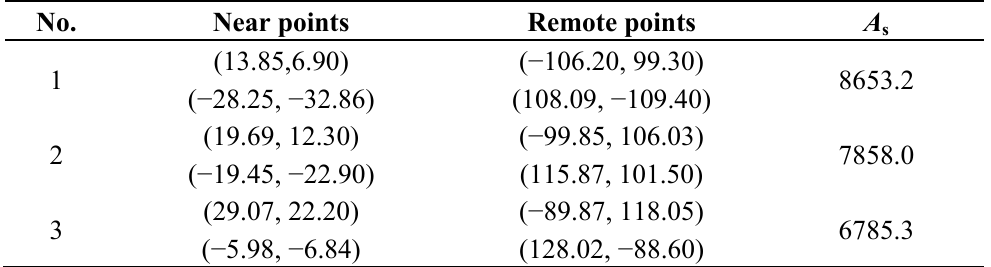
Table 2. Area of the security region for different wind penetration